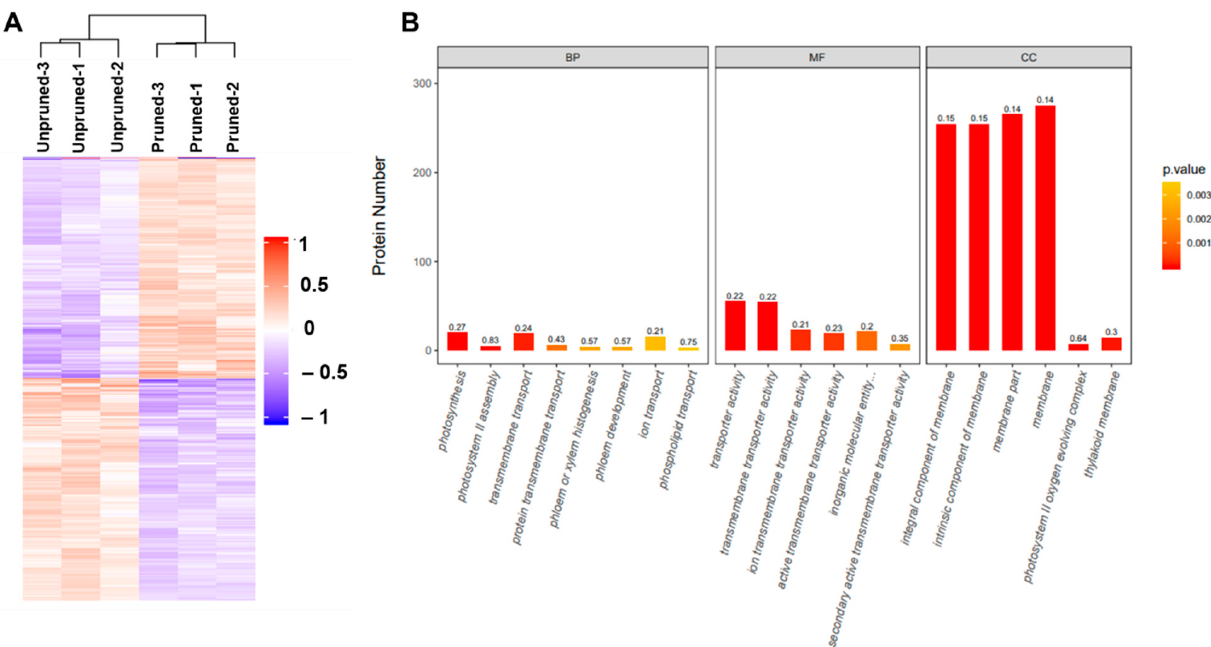
Figure 2. Hierarchical cluster ( A ) and gene ontology classification ( B ) for differentially expressed proteins in leaves of pruned versus unpruned tea plants. The ordinate indicates the number of differential proteins for each functional classification, the color of the bar chart represents the significance of enriched GO functional classification, the color gradient represents the size of p value. The label at the top of the bar chart shows the enrichment factor (richFator ≤ 1), which represents the proportion of the number of differentially expressed proteins annotated to a GO functional class to the number of all proteins identified to that GO functional class. BP, biological process; MF, molecular function; CC, Cellular Component.